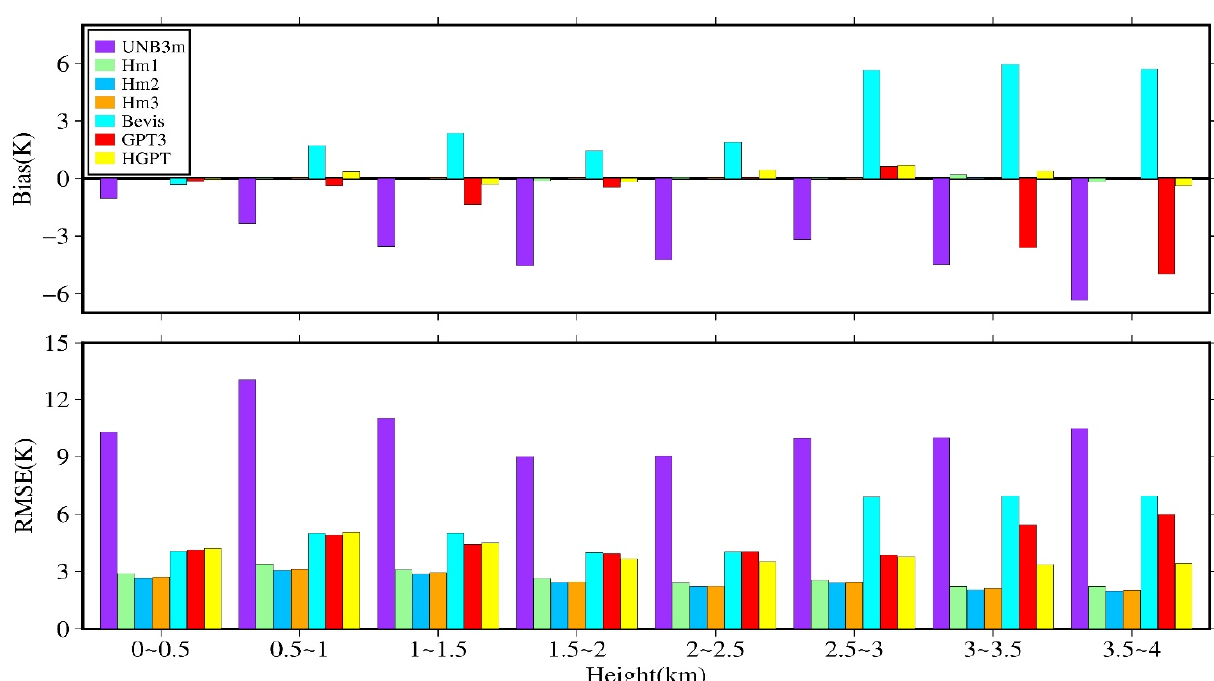
Figure 11. Biases and RMSEs of each model at different heights.